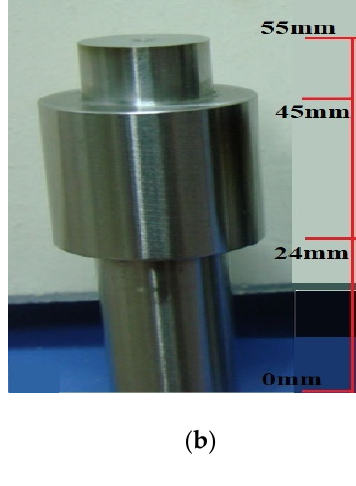
( d ) Figure 1. ( a ) FSP machine ( b ) FSP tool ( c ) groove formed ( d ) B4C/TiO 2 /Gr inserted in the groove on the substrate material. 2.3. Capping Process The capping technique was performed using a pinless FSP tool attached to a milling machine. Using a rotating tool, the grooves were sealed with TiO 2 , B 4 C, and Gr nano-pow- ders. The depth of the capping was 0.3 mm. The pinless FSP tool was constructed from ASP 23 high-speed steel. An 800-rpm tool rotation rate, 30 mm/min tool traverse speed, and 0° tool tilt angle were the processing conditions for the capping pass. In Table 2, the seven different tool rotation rates (800, 1000, 1200, 1400, and 2000 rpm) and traverse speed (25–45 mm/min) for the stirring processes are provided. The purpose of the groove in the plates was to improve powder dispersion and reduce the amount of powder that accu- mulated on the advancing side during FSP. Table 2. FSP parameters used for the fabrication of FSPed AA 7075/TiO 2 /B 4 C/Gr surface composite specimens. Samples Numbers from 1 to 36 Processing Parameters AA7075/TiO 2